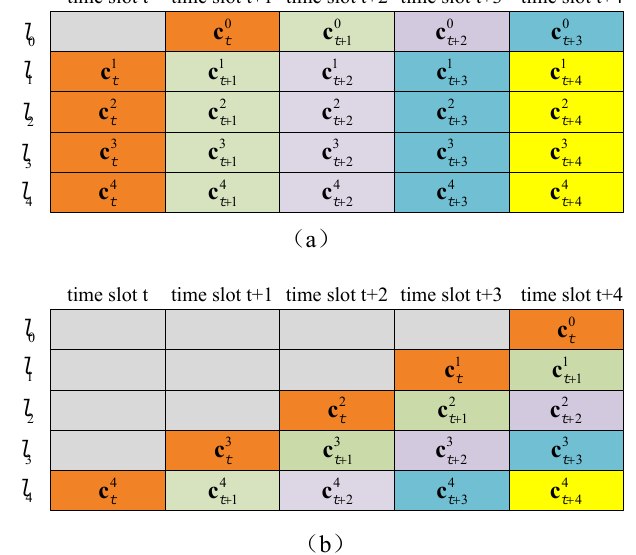
Figure 2. Two delay patterns for 32-QAM. ( a ) The delay pattern D = { T 0 = 1, T 1 = T 2 = T 3 = T 4 = 0 } . ( b ) The delay pattern D = { T 0 = 4, T 1 = 3, T 2 = 2, T 3 = 1, T 4 = 0 }